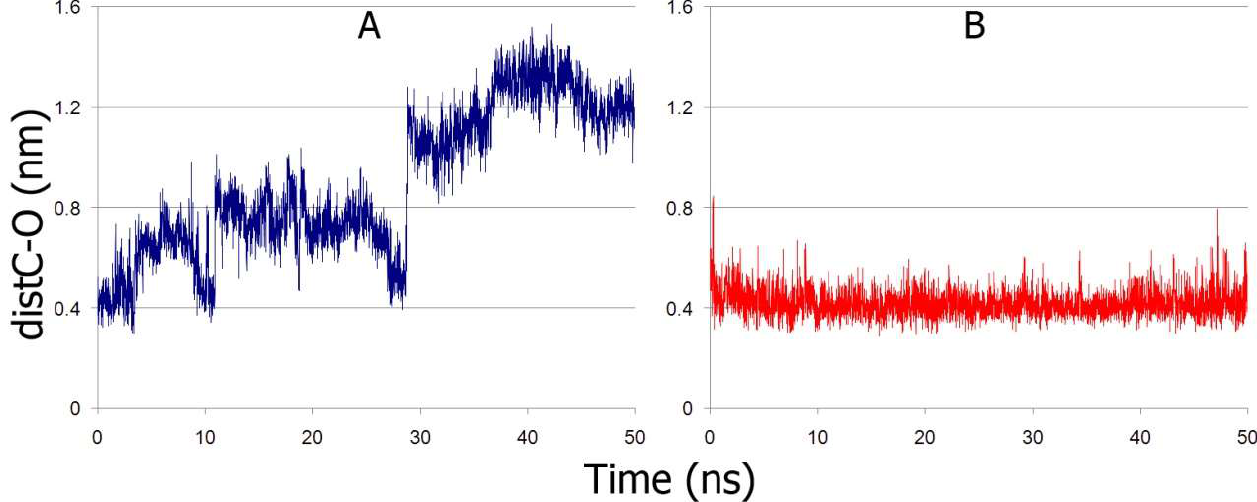
Figure 8. Time change of the distance (distC-O) between the carbonyl carbon of NPA and the hydroxyl oxygen atom of catalytic tyrosines of oxidised BSA according to MD simulation. ( A ) Sudlow site I with catalytic tyrosine Tyr149, ( B ) Sudlow site II with catalytic Tyr410.